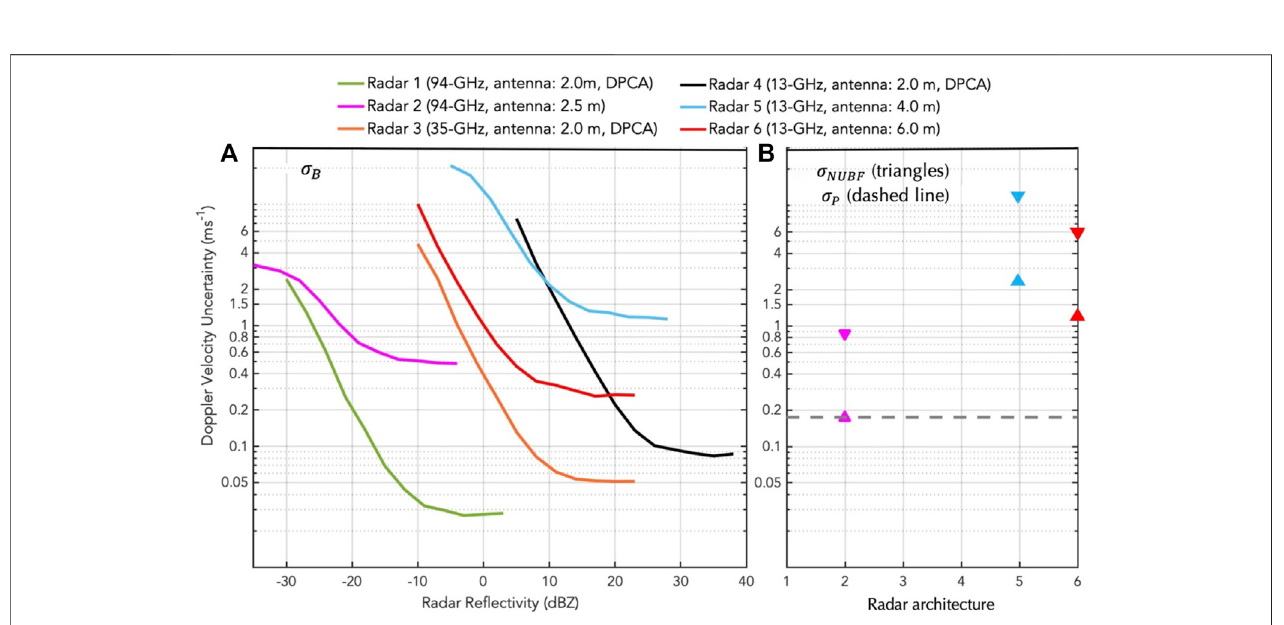
FIGURE 7 | Doppler velocity uncertainty from (A) spectral broadening ( σ B ) and (B) non-uniform beam fi lling ( σ NUBF ; triangles), and mis-pointing ( σ P ; dashed line). Results are shown for the 6 radars under consideration (color coded as in Table 1 ).